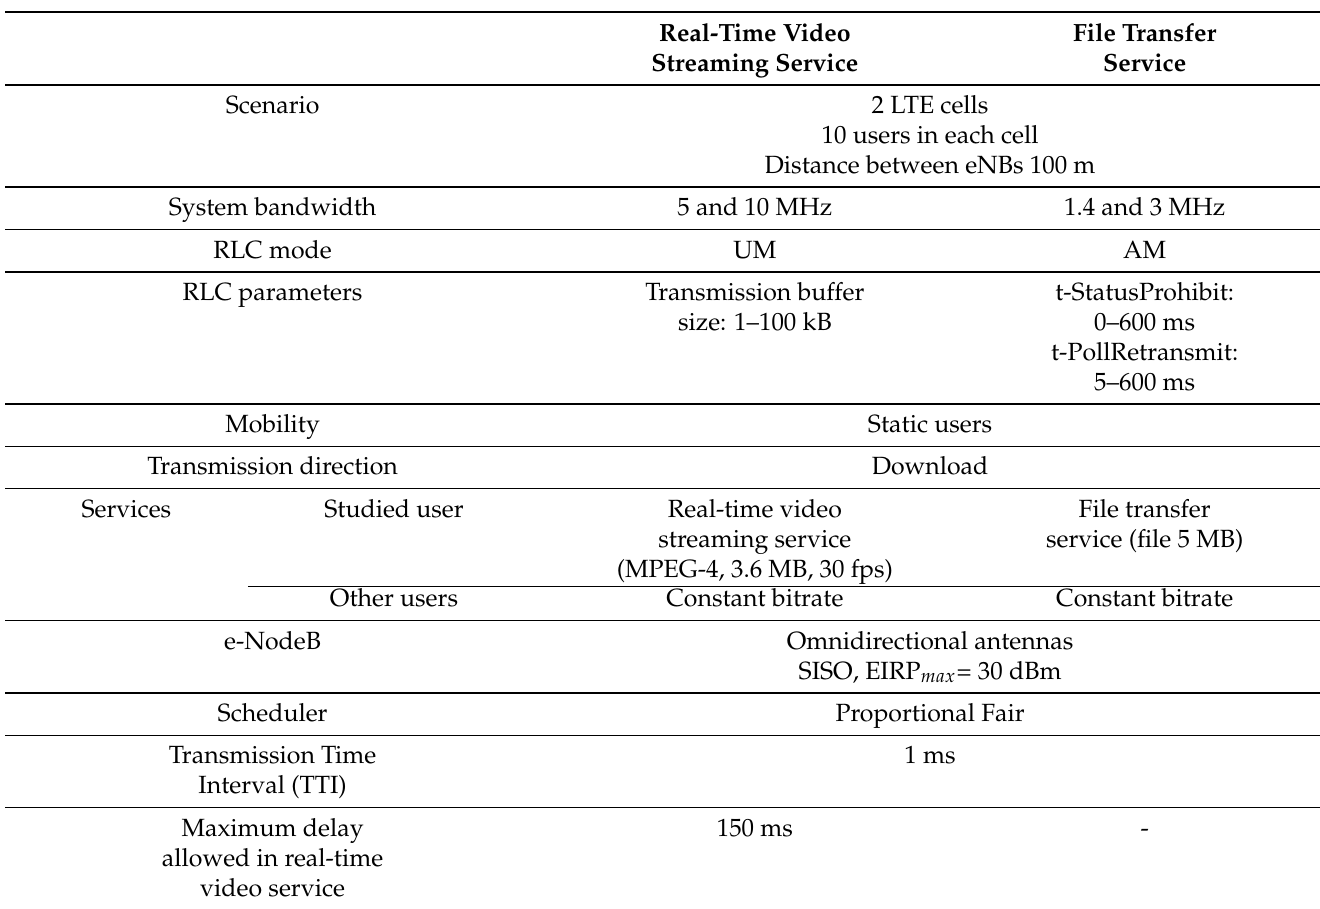
Table 1. Configuration of ns-3